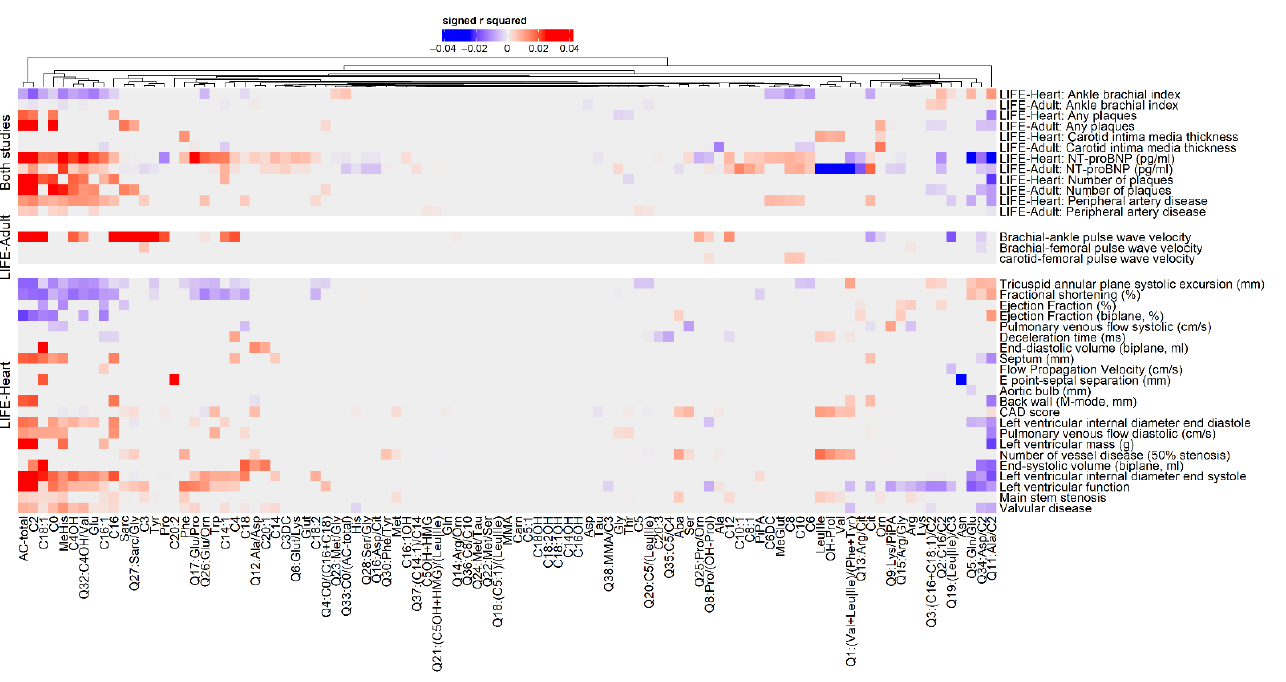
Figure 1. Associations of whole blood metabolites as response variable with ASCVD phenotypes, adjusted for 15 risk factors and confounders in LIFE-Adult and LIFE-Heart. Partial explained variance (partial-r 2 ) and direction of effects are displayed for significant associations fulfilling hierarchical FDR < 5% (color indicates significance and direction of effect, intensity of color indicates effect size). Only significant associations are depicted. All statistics are shown in supplemental Table S4. Phenotypes are presented in three groups: “both studies” comprise phenotypes available in both studies, while the other groups are study-specific. Hierarchical clustering based on Euclidean distance using the complete linkage method was applied for metabolites and phenotypes within each